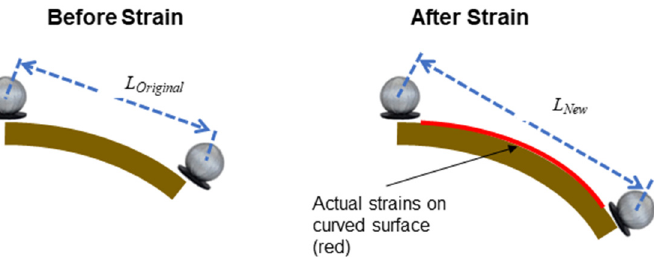
Figure 4. The illustration depicts errors when estimating surface strains when using the linear dis- tance between two mocap markers.